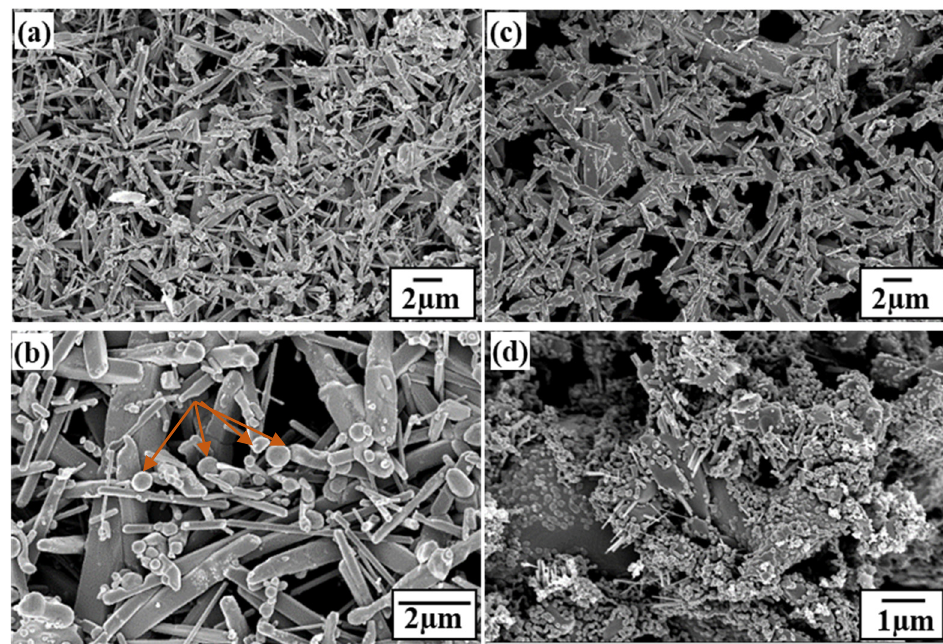
Figure 13. SEM analyses of the quenched sample at 1263 K ( a , c ) and 1573 K ( b , d ). In some regions of the sample quenched at 1573 K, Mo and Cu nanoparticles were homogeneously distributed in the nanometer range (Figure 14).